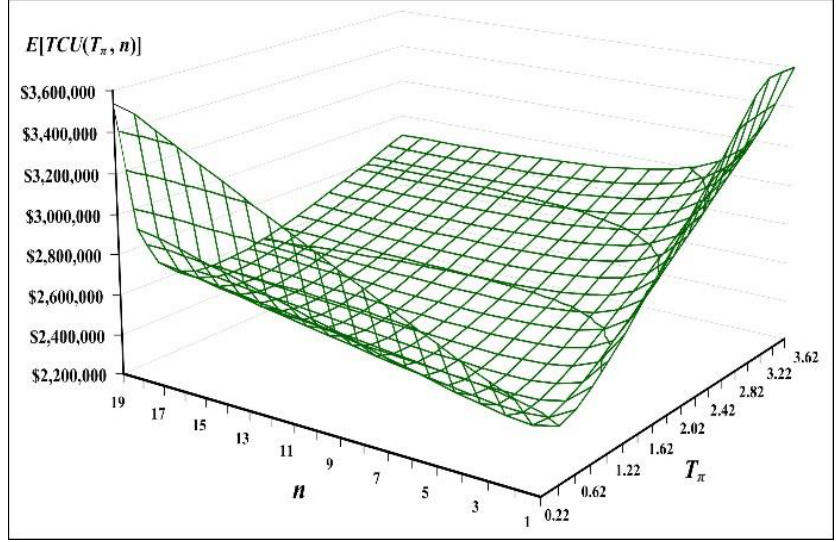
Figure 3. Joint impacts of variations in n and T π on E[ TCU ( T π *, n